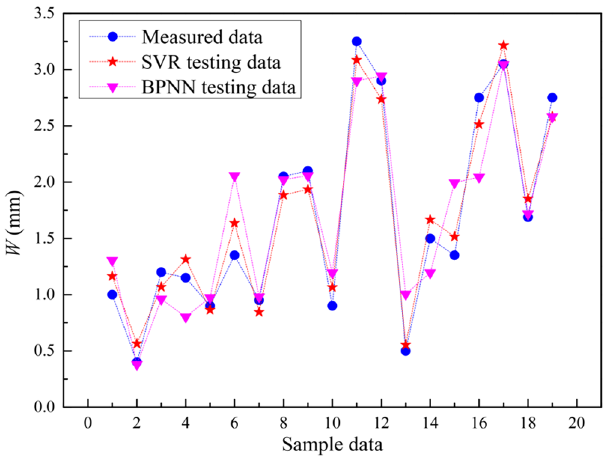
Fig. 8. Comparing of SVR and BPNN on the testing results.